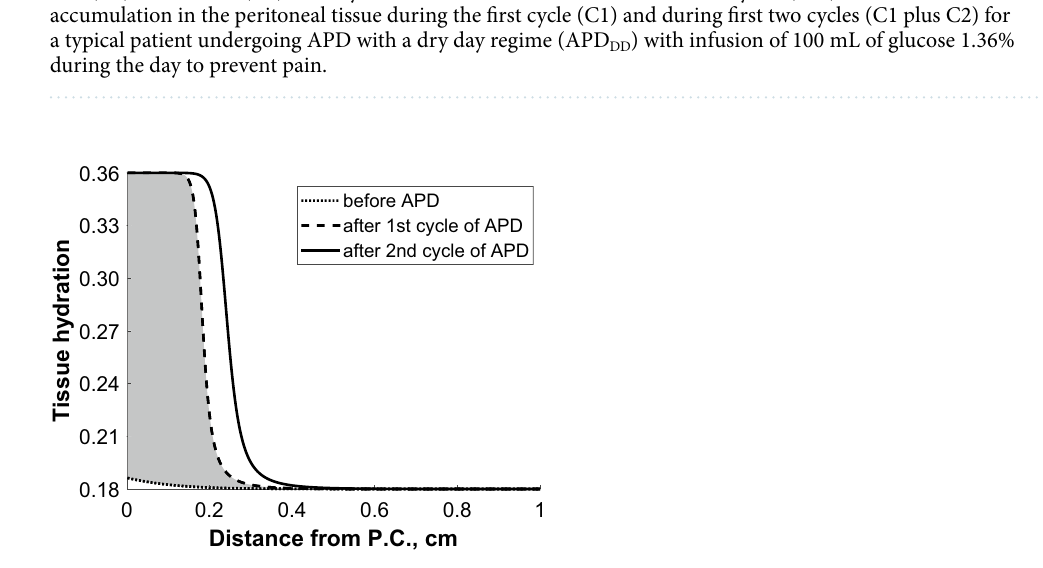
Figure 3. Predictions by the applied distributed model 2, 7 of peritoneal tissue hydration as a function of distance from the peritoneal cavity (P.C.) and changes during APD with dry day followed by night APD exchanges (APD DD regime). Dotted line—before starting of APD session; dashed line—after the first cycle of APD session; solid line—after the second cycle of APD session. Before starting of APD session, the tissue hydration profile is slightly above the physiological level of tissue hydration of 0.18 (18%) that is typically kept in deeper tissue layers. The shadowed area denotes the change in tissue hydration occurring during the first cycle of APD